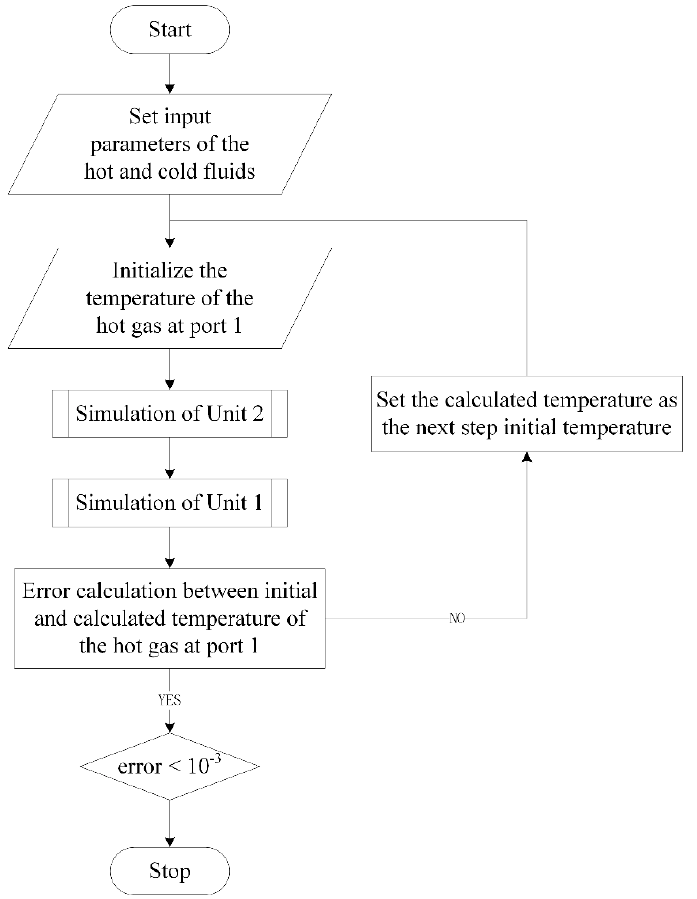
Figure 5. Calculation process of the chemical reformer.